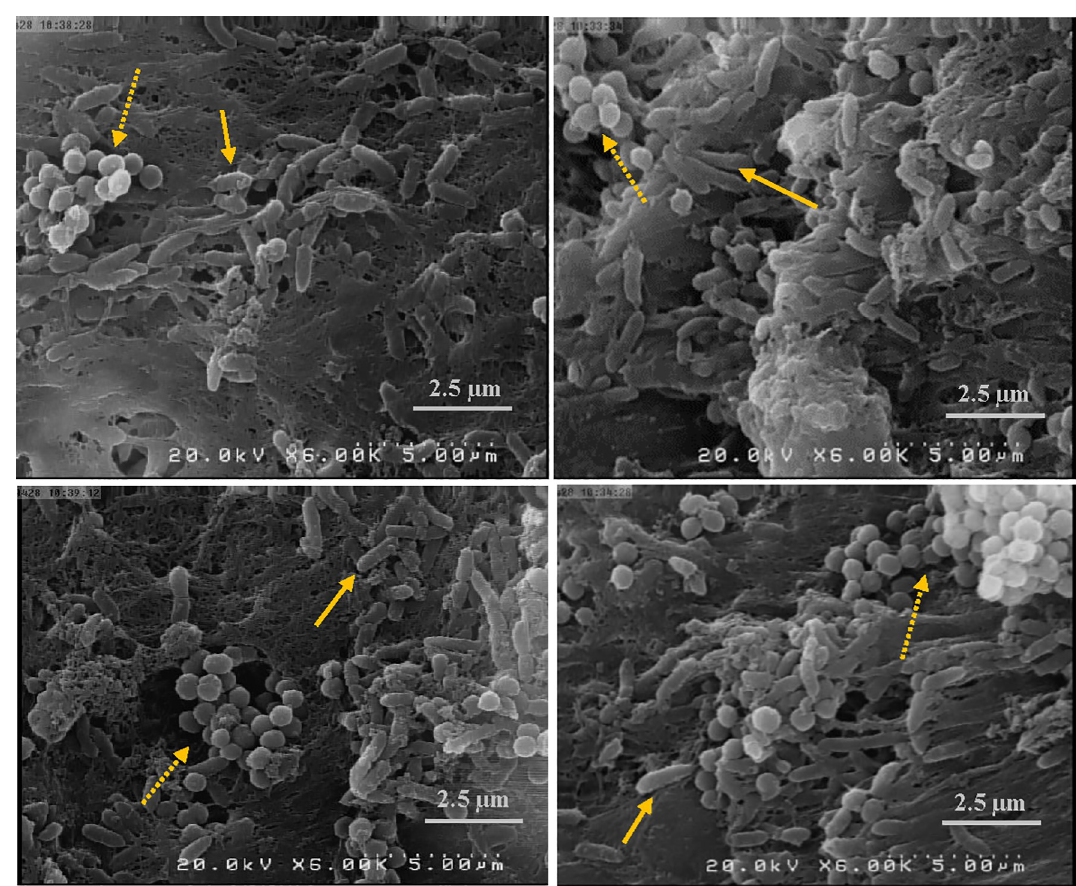
Fig 2. Scanning electron micrographs of S . aureus-P . aeruginosa biofilms. Rod (solid arrow) and cocci bacteria (dashed arrow) are shown. (6000x magnification).